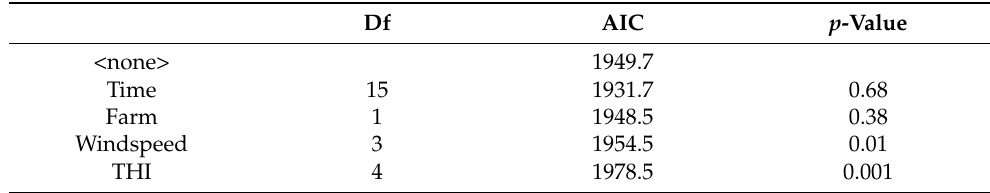
Table 4. Model fit (AIC) and p -values of the linear mixed-effects model testing horn temperature during the 20 min rumination bouts ( n = 41